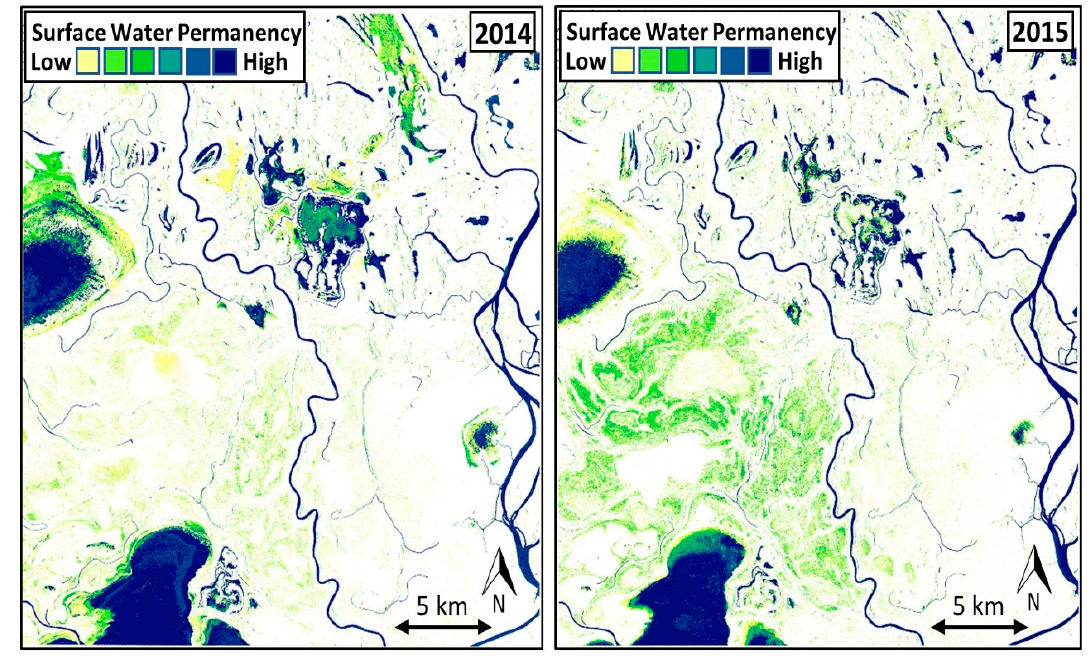
Figure 5. Peace-Athabasca Delta hydroperiod results for 2014 and 2015 showing notable change in surface water permanence over wetlands, with little change in watercourse surface water.